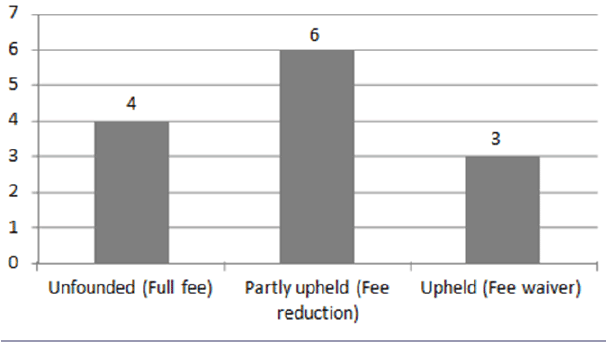
Fig. 2 . Administrative proceeding appeals with published resolutions, 2014–2016. Source: Tribunal de